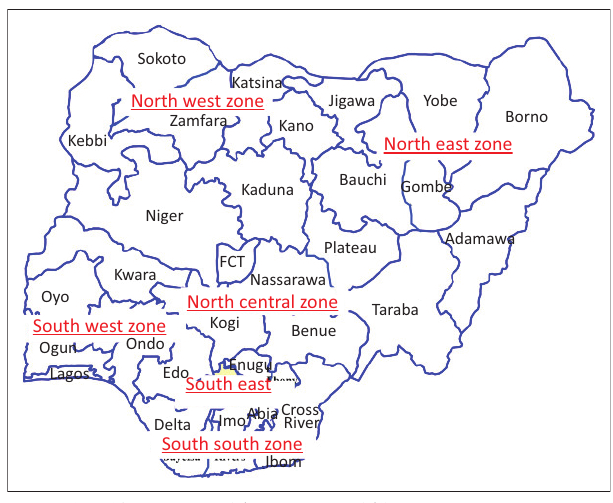
FIGURE 1: The map of 36 states of Nigeria and the 6 geopolitical